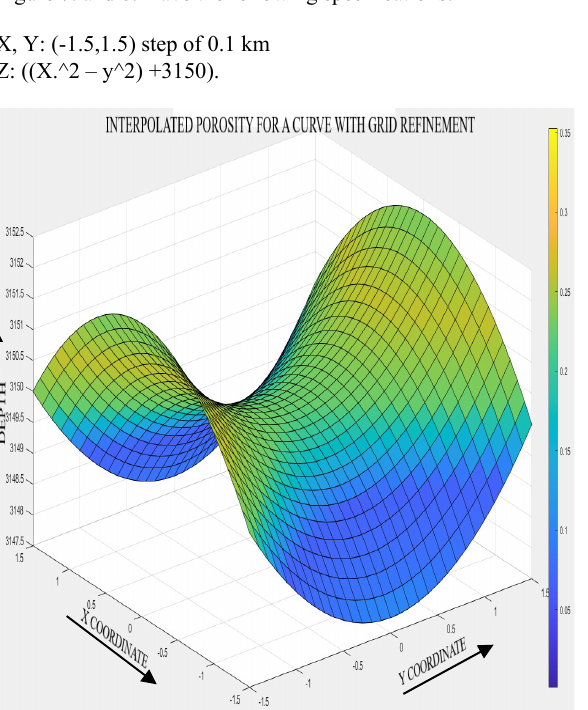
Figure 7. Grid refinement of figure 6.